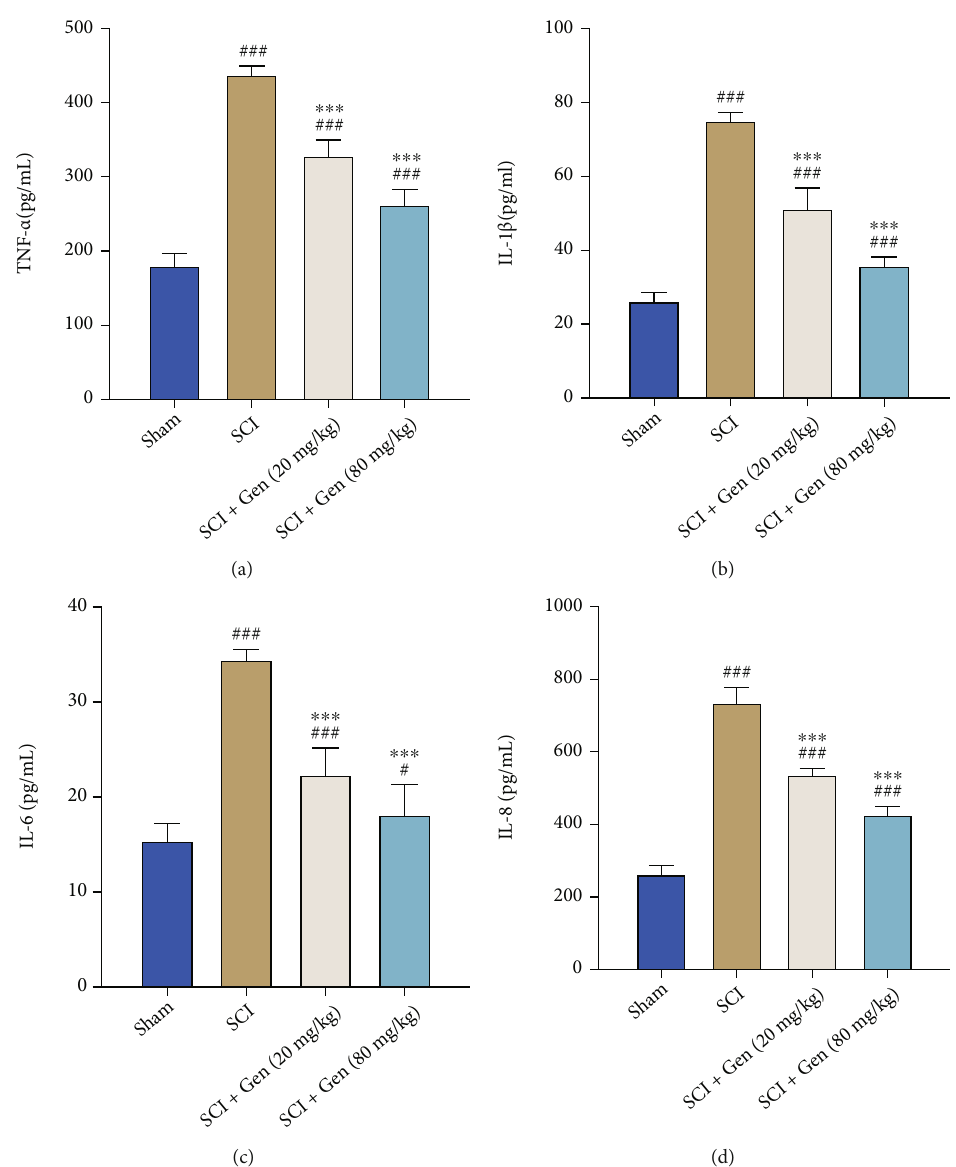
Figure 3: Genistein reduced in fl ammation in SCI mice. (a – d) 28 days after genistein treatment, we measured the content of TNF- α (a), IL- 1 β (b), IL-6 (c), and IL-8 (d) in the SCI area using ELISA kit. Five mice in each group, and data were expressed as mean ± SD . P value was calculated by post hoc comparisons. ∗∗∗ P < 0 : 001 vs. SCI group. # P < 0 : 05 and ### P < 0 : 001 vs. sham